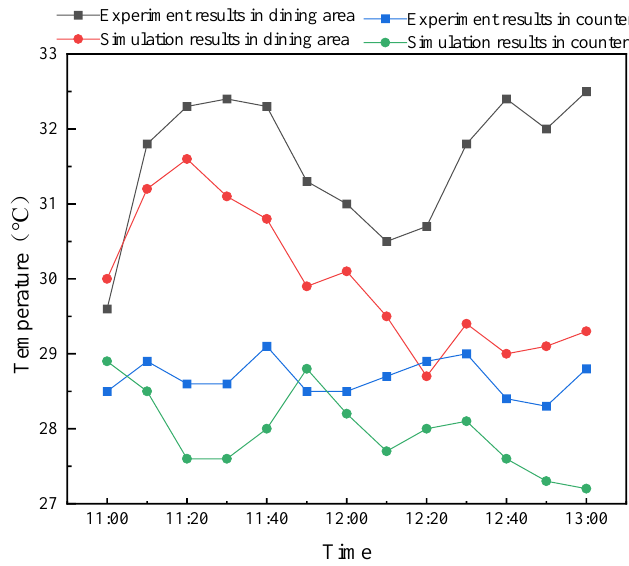
Figure 12. Simulation vs. measured results for measuring points.